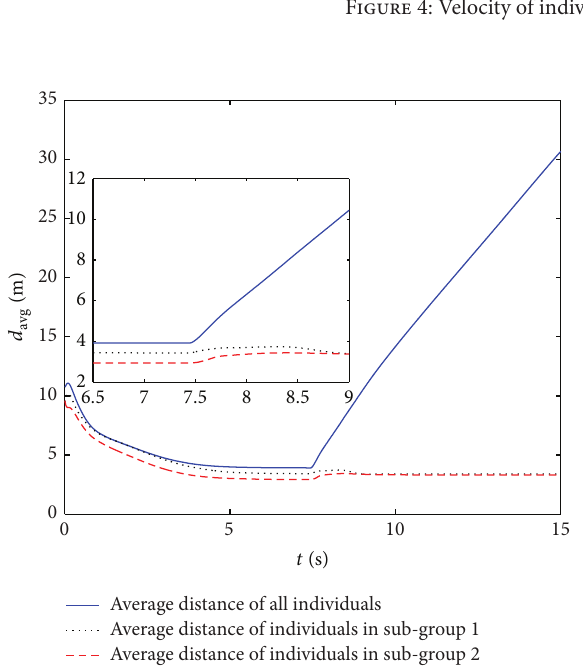
Figure 5: Average distance of the whole group and two separated subgroups.